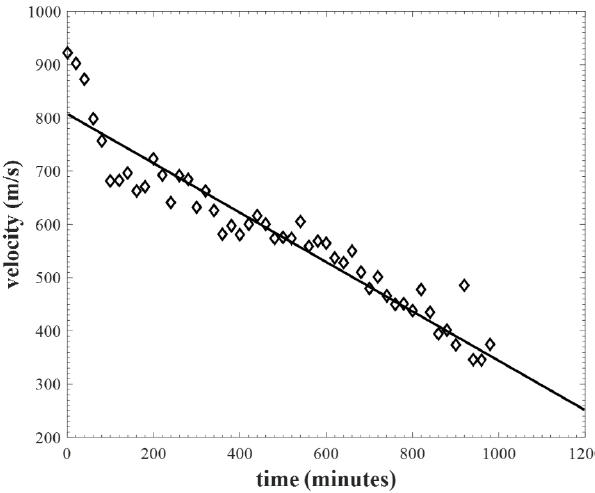
Figure 6. Longitudinal wave velocity decreasing as a Rockwool insulation sample is first saturated with water, and then left to dry out with time at room temperature.